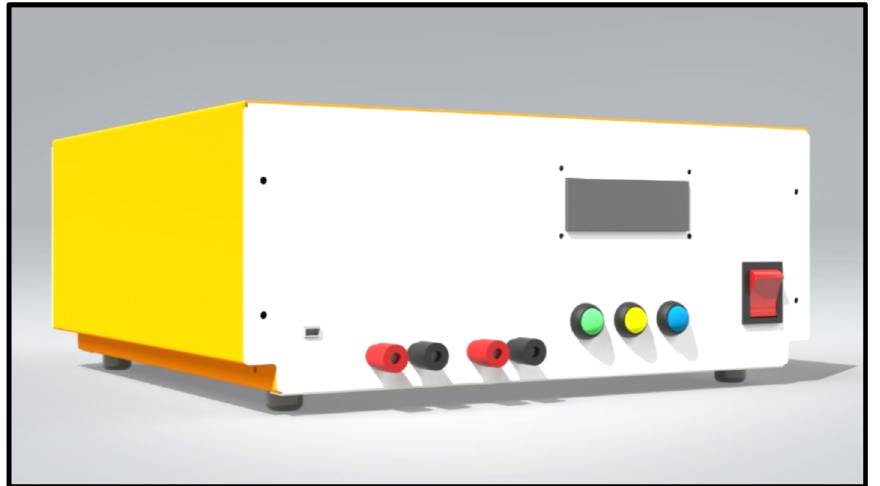
Figure 3. Proposed WEC emulator to be constructed.